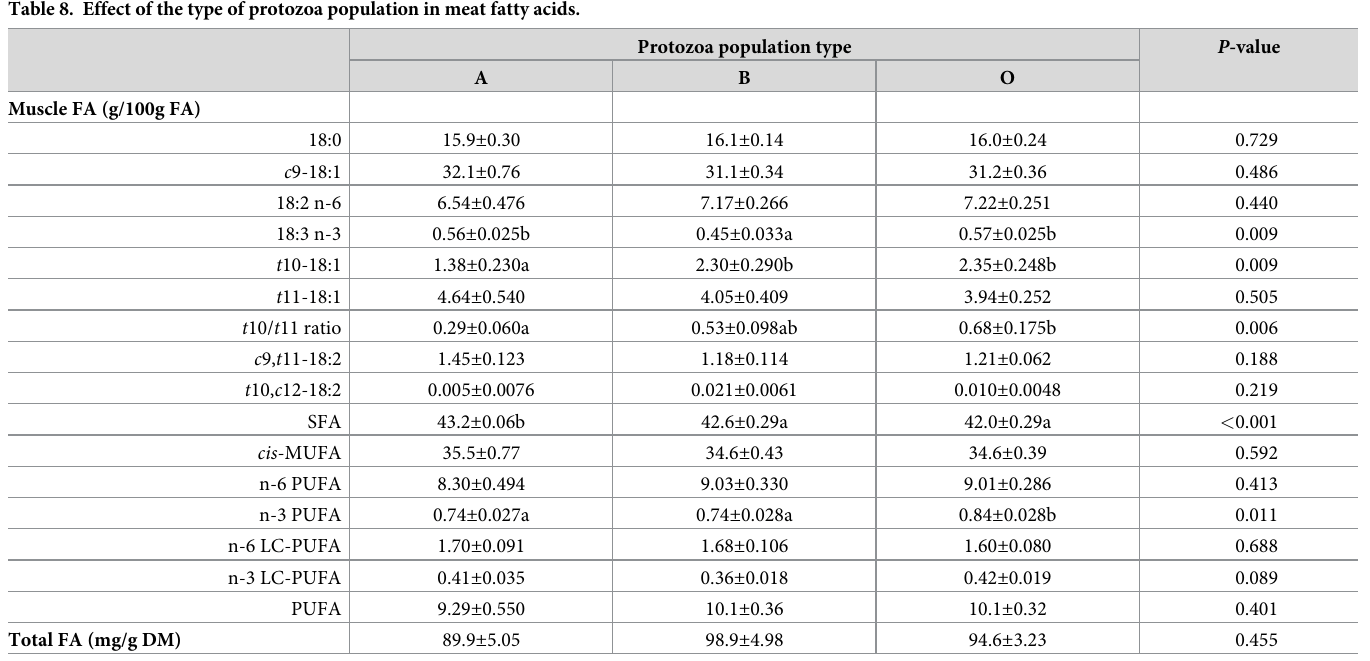
Table 8. Effect of the type of protozoa population in meat fatty